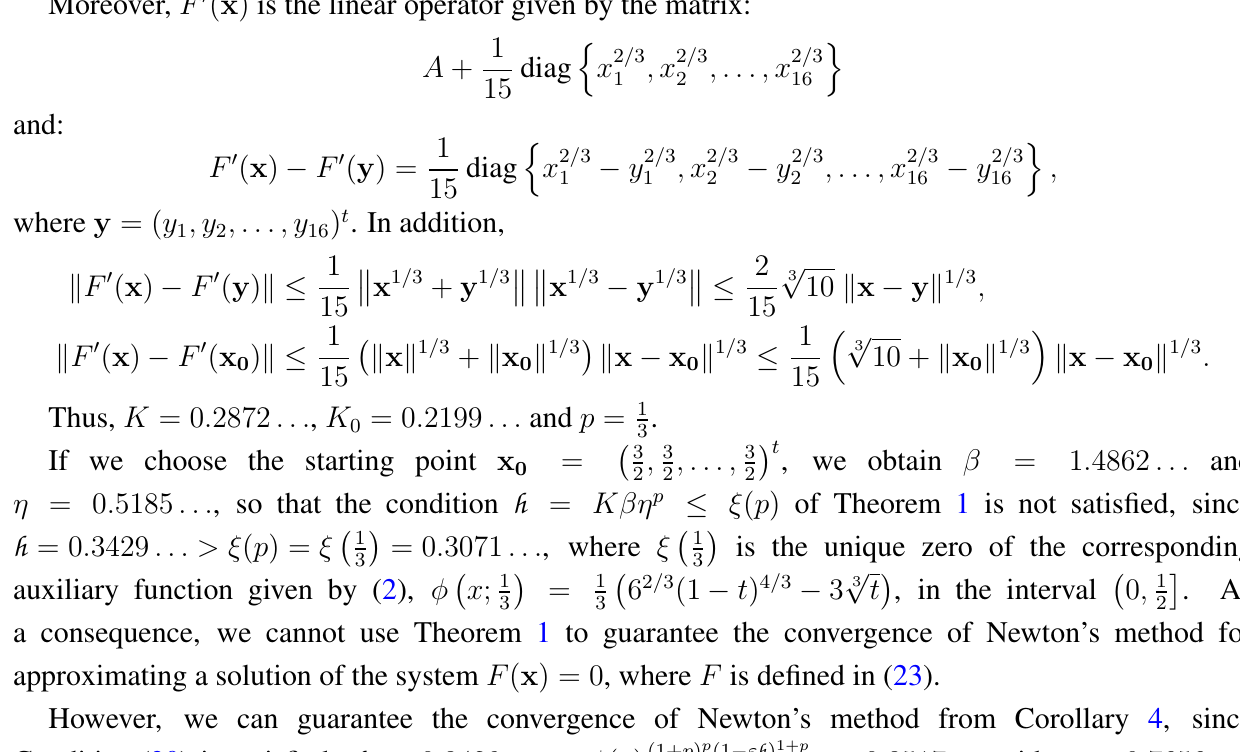
Table 1. Approximation of the solution x ∗ of F ( x ) = 0 with F given in (23).